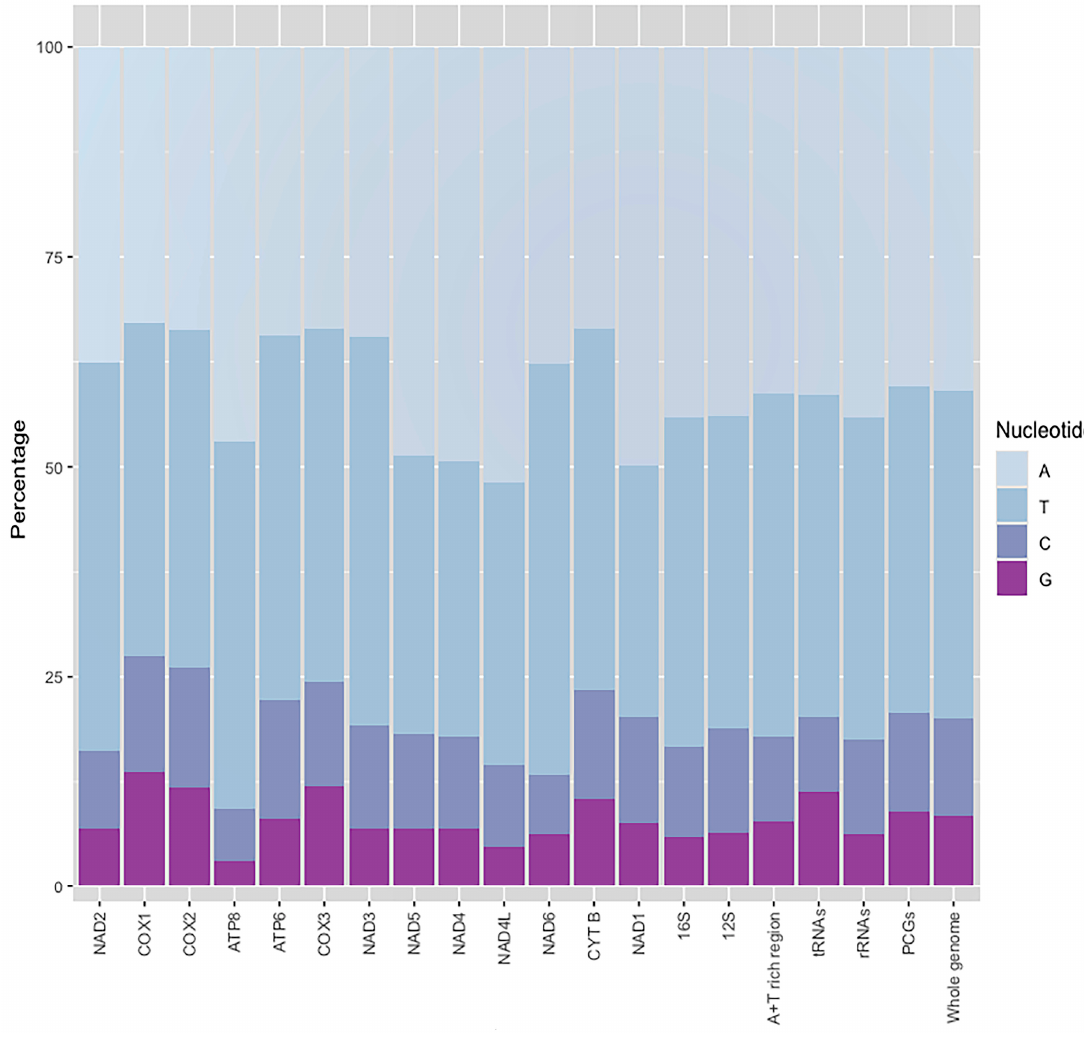
Figure 7. Nucleotide composition of the Eriopis patagonia mitogenome. Protein-coding genes (PCGs), transfer RNAs (tRNAs), and ribosomal RNAs (rRNAs).